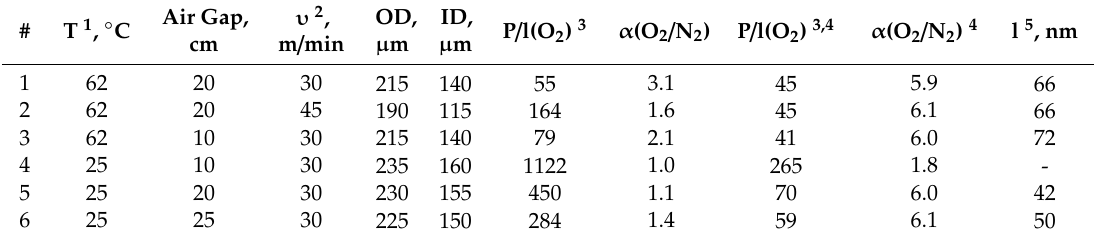
Table 1. The influence of spinning parameters on hollow fibers’ geometrical and gas separation characteristics before and after polydimethylsiloxane (PDMS)